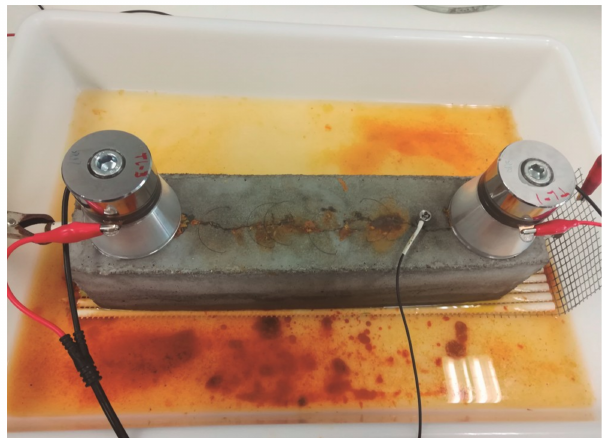
Figure 5. Photo of the M3-reinforced mortar specimen near the end of the corrosion test.